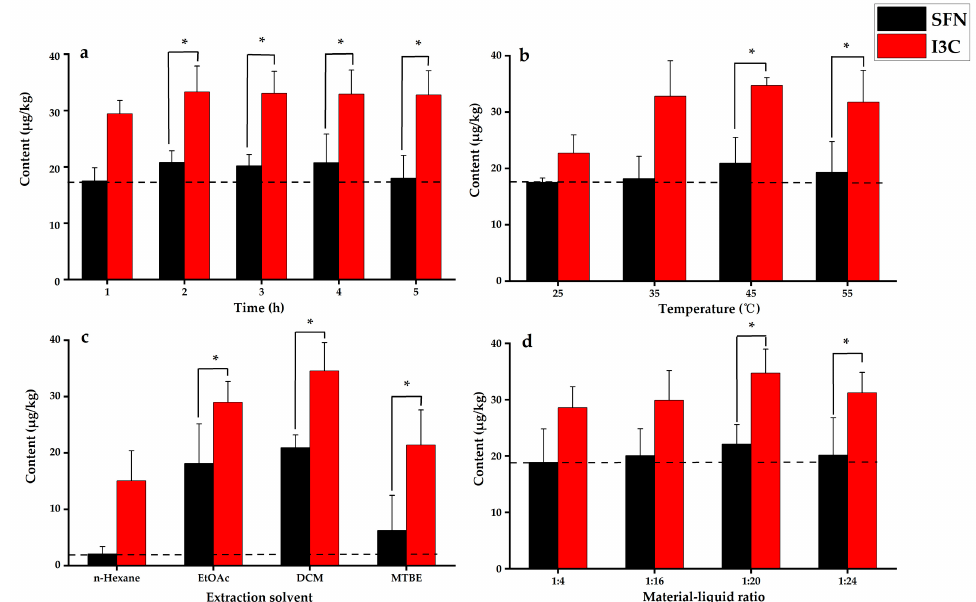
Figure 2. Optimized extraction conditions: ( a ) effect of hydrolysis time, ( b ) effect of temperature, ( c ) effect of solvent type, ( d ) effect of extraction solvent volume. “*” with brackets represent significant differences of SFN and I3C, p < 0.05.